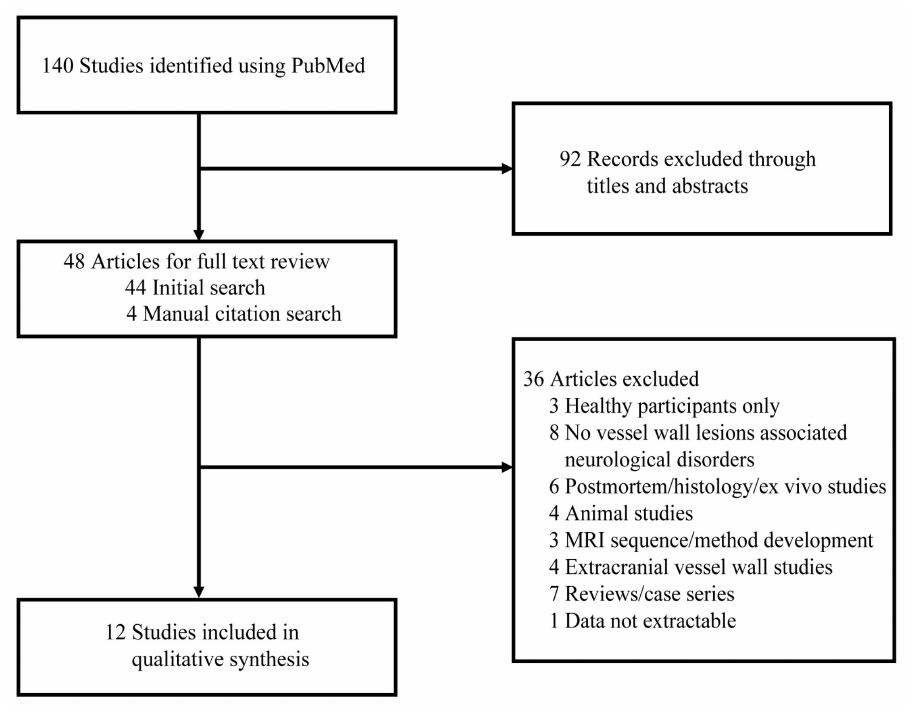
Figure 1. Flow diagram of the study selection. Abbreviations: MRI, magnetic resonance imaging.